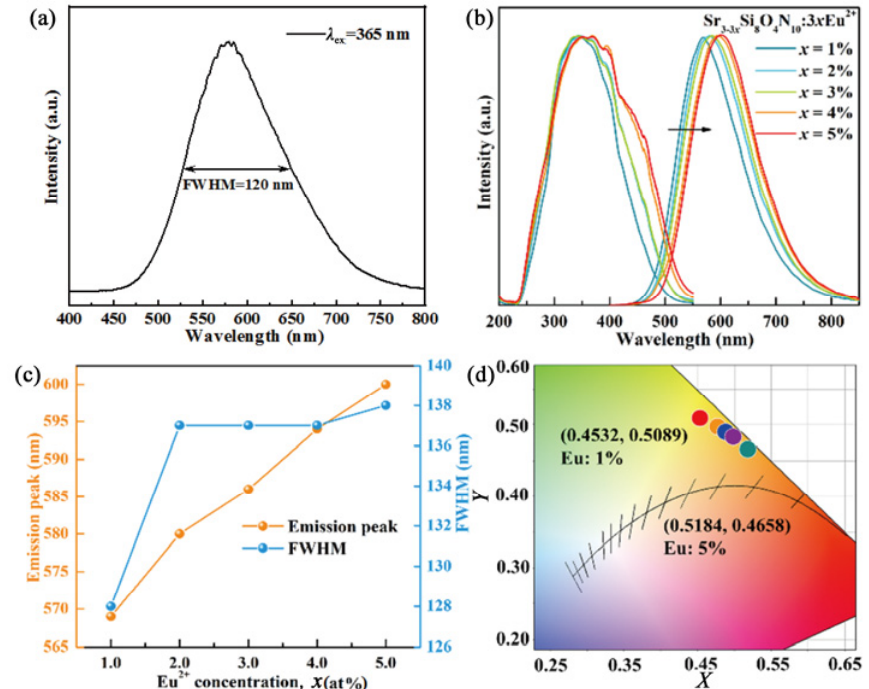
Fig. 5 PL spectra of Sr 3 − 3 x Si 8 O 4 N 10 :3 x Eu 2+ . (a) Emission spectrum of single crystal pinpointed from the fired powder mixture; (b) emission and excitation spectra of Sr 3 − 3 x Si 8 O 4 N 10 :3 x Eu 2+ phosphor powders with varying x (1–5 at%); (c) maximum emission and FWHM as a function of x ; and (d) chromaticity coordinates of phosphor powders with varying x